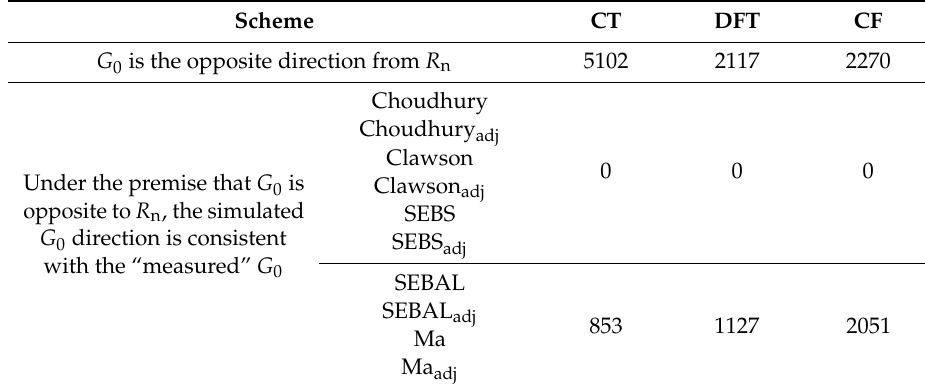
Table 6. Simulation effect of each scheme on the direction of ground surface soil heat flux ( G 0 ) when G 0 is the opposite direction from net radiation ( R n ).